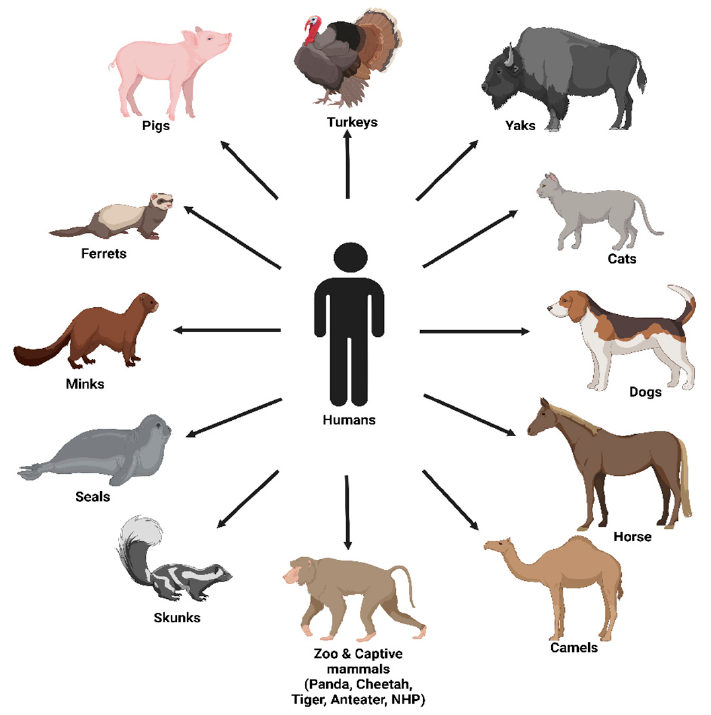
Figure 4. Transmission of human influenza viruses to animals (reverse zoonoses).